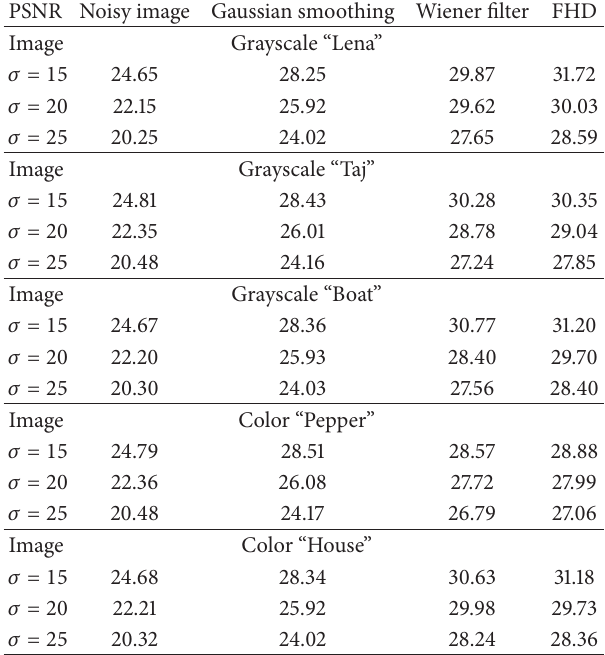
Table 1: PSNR of denoised images with different Gaussian noise